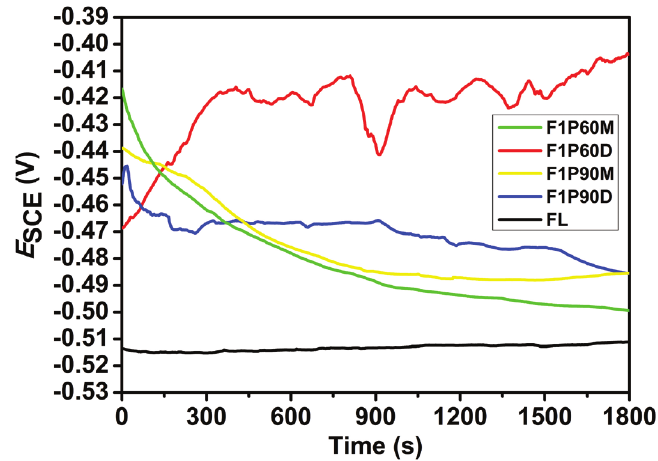
Figure 5. Open circuit potential (OCP) monitoring for all the hybrid films and the uncoated tinplate.